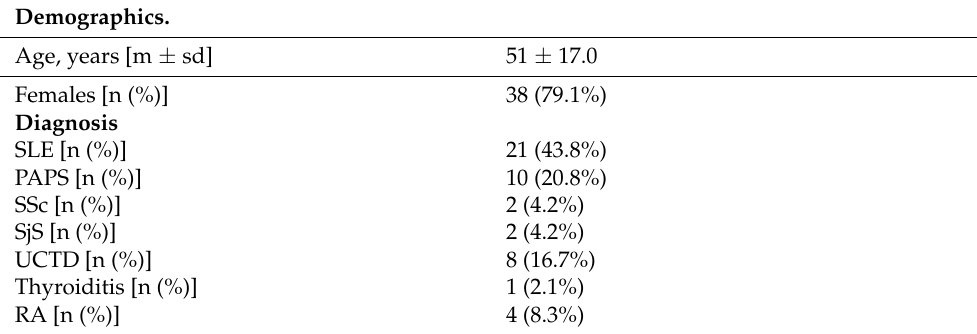
Table 1. Main characteristics and diagnoses of patients.